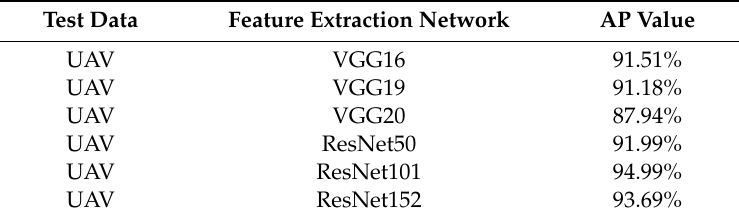
Figure 7. Probability for maize tassel detection with different feature extraction network models. ( a – represent feature extraction networks. f ) represent feature extraction networks. Table 1. Test results with di ff erent feature extraction Table 1. Test results with different feature extraction models .